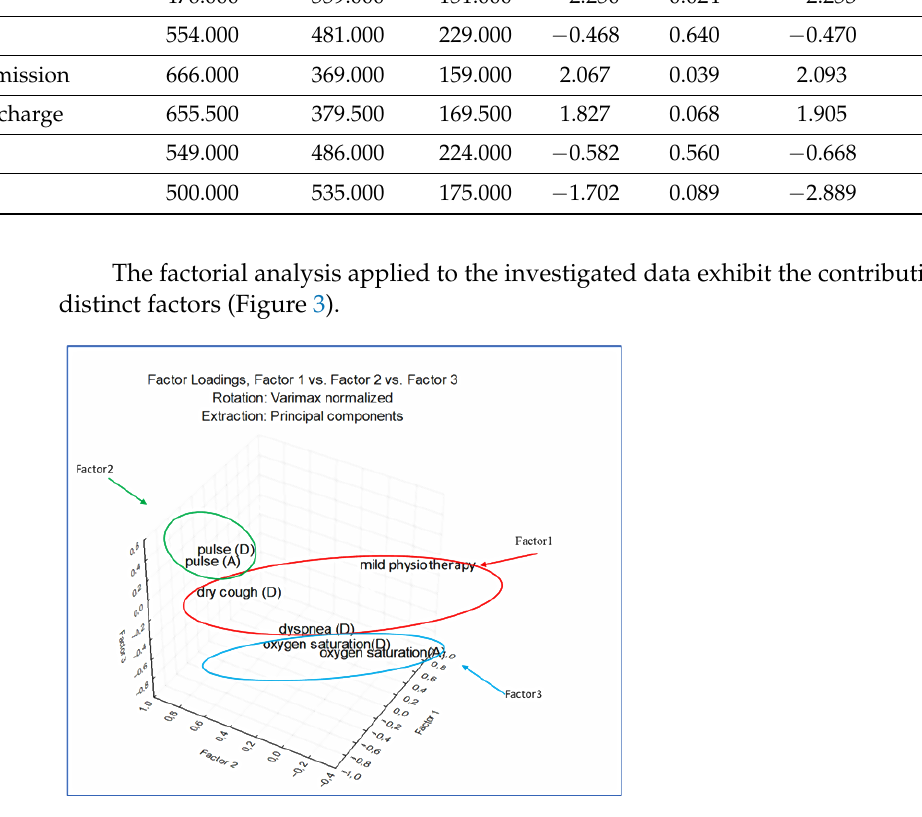
Figure 3. Graphical representation of factor weights in the case of patients who performed mild and active physiotherapy.